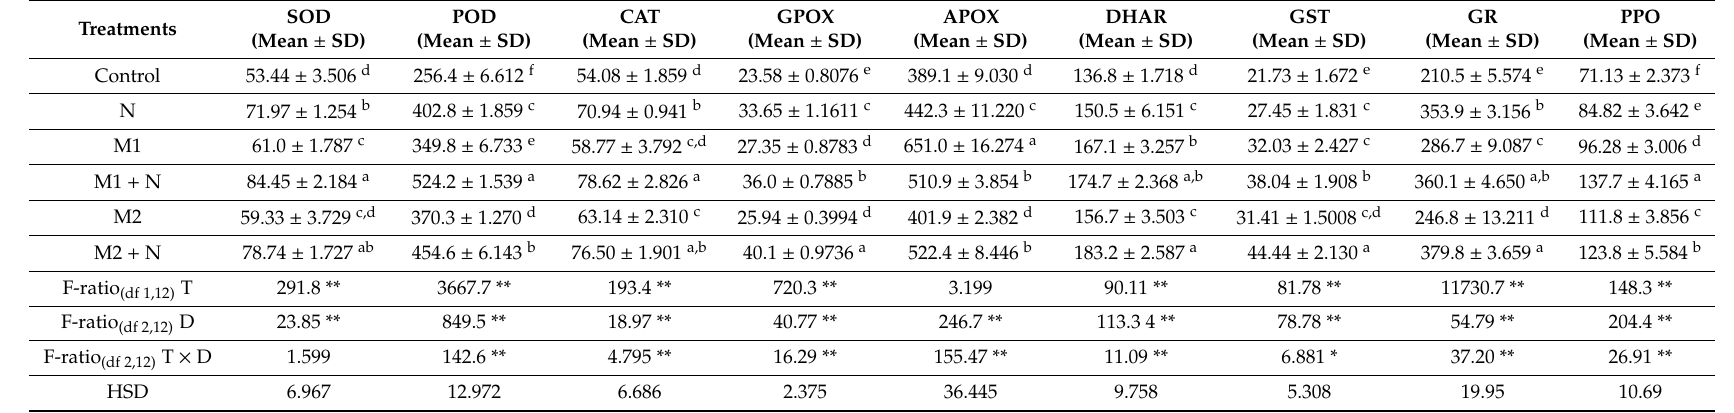
Table 3. E ff ect of M1 (10 9 cells / mL) and M2 (10 9 cells / mL) on: SOD, POD, CAT, GPOX, APOX, DHAR, GST, GR, PPO in 45-days old L. esculentum plants under PPN infection. Data is presented as means of three replicates ± SD and HSD values. F ratio values, * indicates significance at p ≤ 0.05 and ** indicates significance at p ≤ 0.01). Di ff erent letters on the graphs indicate that mean values of treatments are significantly di ff erent at p < 0.5 according to Tukey’s multiple comparison